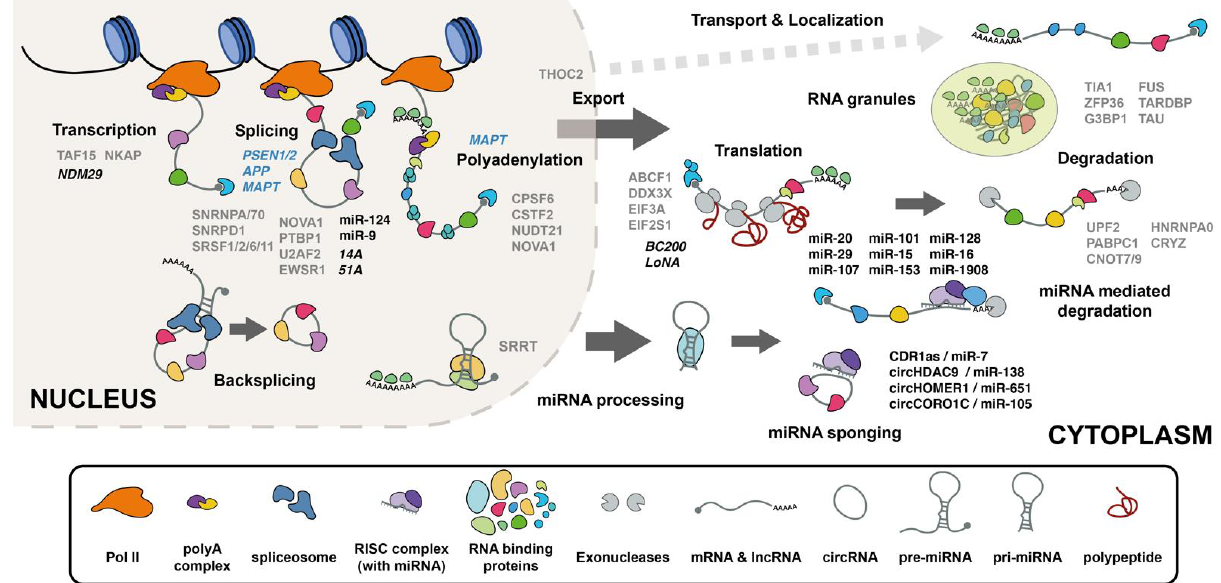
Figure 1. RNA processing in AD. Schematic representation of the main processes regulated by RBPs and RNAs within cells and their alterations in AD. The figure depicts the biogenesis of the main coding and non-coding RNA species, including mRNAs, lncRNAs, miRNAs, and circRNAs, as well as the main RNA regulatory processes, including transcription, splicing, RNA transport, storage, translation, and RNA degradation. Additionally, we highlight some of the known RNA processing alterations described in AD, including (1) changes in the expression of mRNA isoforms of AD-related genes (blue); (2) RBPs with altered function (grey); and (3) miRNA and lncRNA with altered expression (black). Genes, RNAs, and RBPs appear next to the relevant biological process to which they are related.